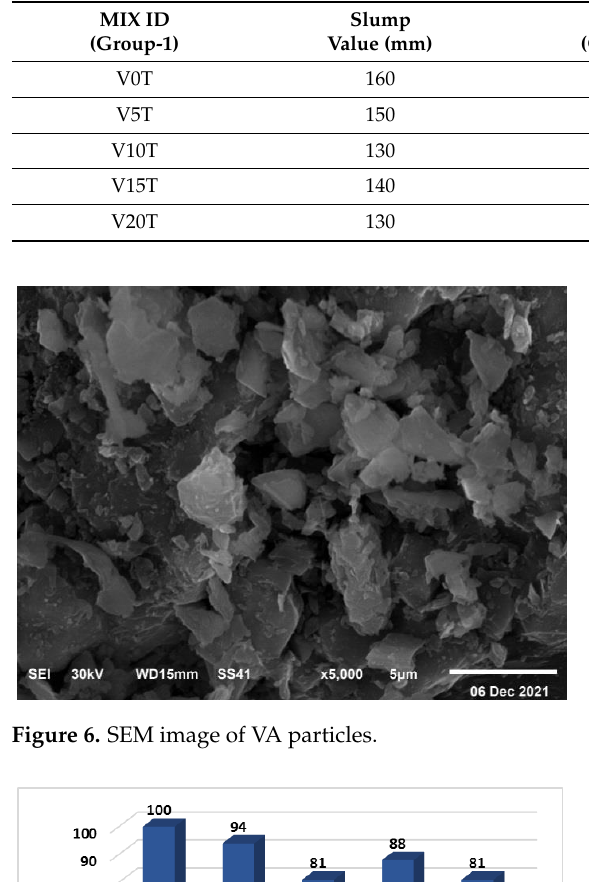
Table 7. Slump values of volcanic concrete.